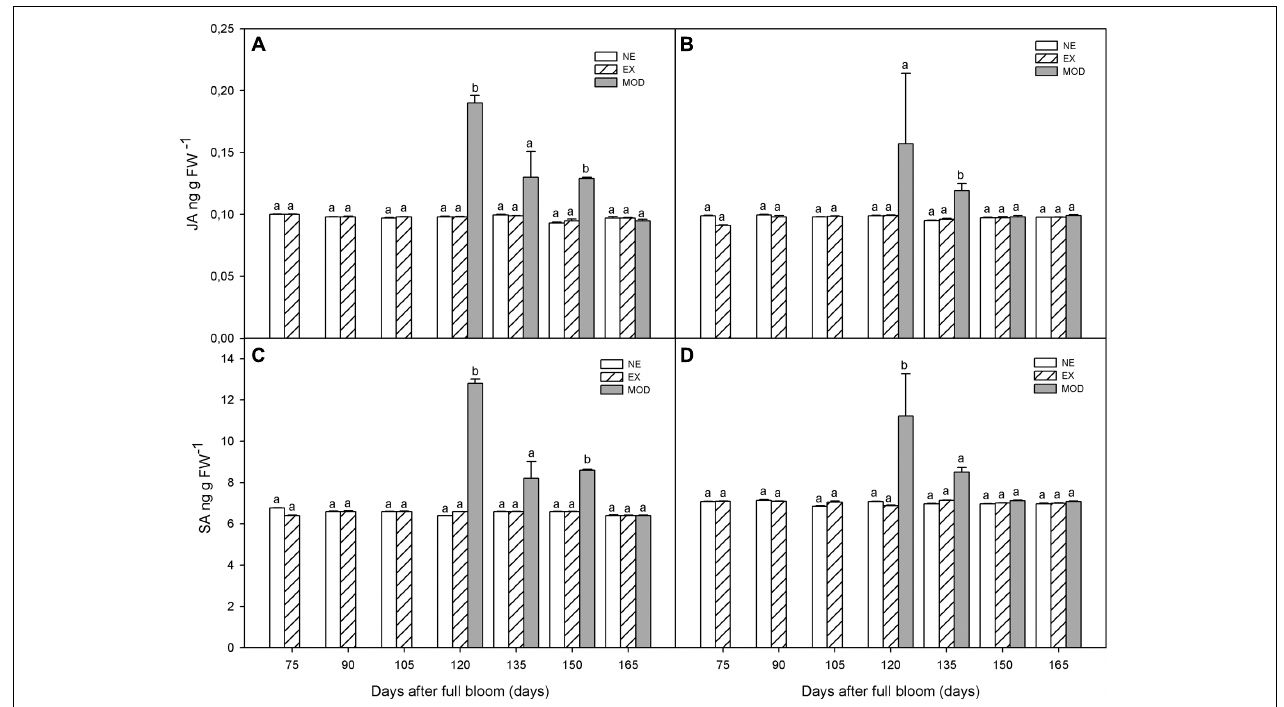
FIGURE 3 | Jamonic acid (JA) (A,B) and salicylic acid (SA) (C,D) concentrations in apple skin during fruit development of non-exposed (NE), exposed (EX), and moderate sun-damaged (MOD) fruit from orchards Quilpue (A,C) and Los Lirios (B,D) , Maule Region, Chile. Different lower-case letters indicate statistical difference ( P ≤ 0.05) between sun damage levels at each time point. Values represent means ± SE of 3 biological